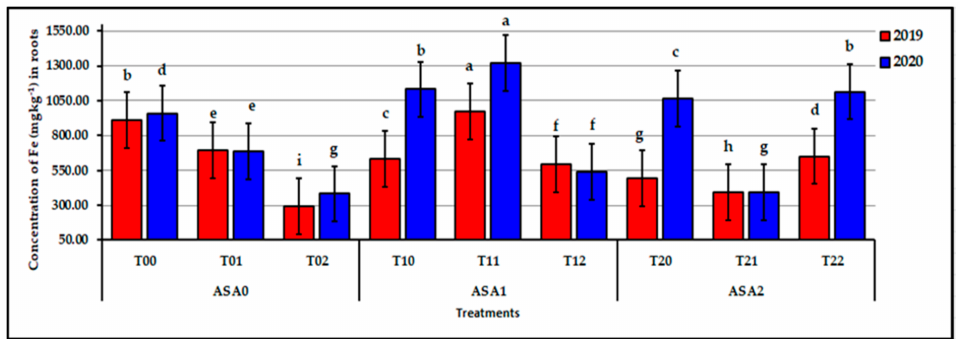
Figure 5. Influence of interaction between zinc oxide nanoparticles and ascorbic acid on root Fe content of stressed sweet potato plants in 2019 and 2020 seasons. Bars with a different letter indicate significant difference between treatments at p ≤ 0.05.